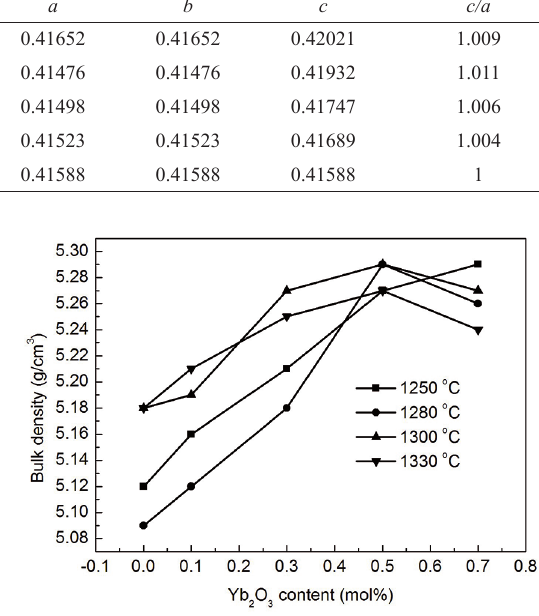
Figure 5: Bulk density of BZT10 + x Yb different temperature.